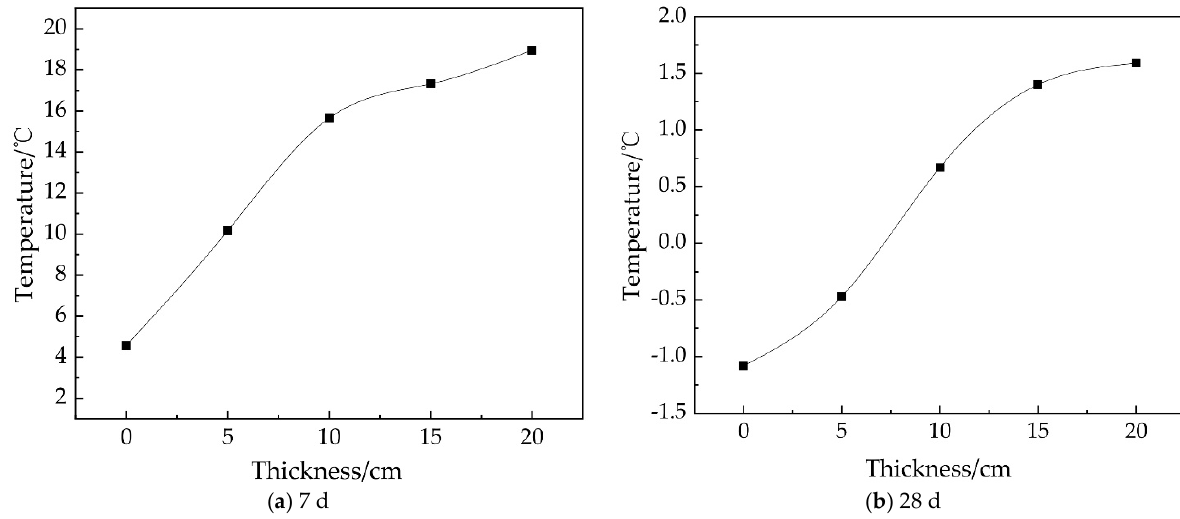
Figure 9. Temperature change of pile foundation at 7.4 m.